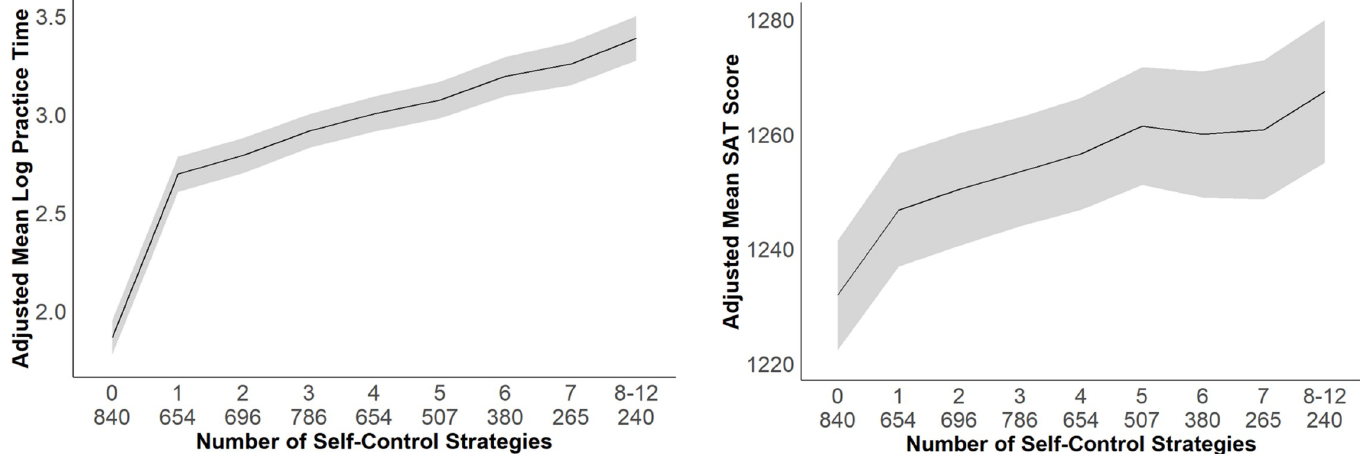
Fig 1. Number of self-control strategies used predicting practice time and SAT scores for Study 1. Study 1 practice time (panel a ) and SAT score (panel b ) as a function of the number of self-control strategies used. Means are adjusted for covariates: PSAT scores, gender, ethnicity, and fee waiver status. Shading indicates 95% confidence